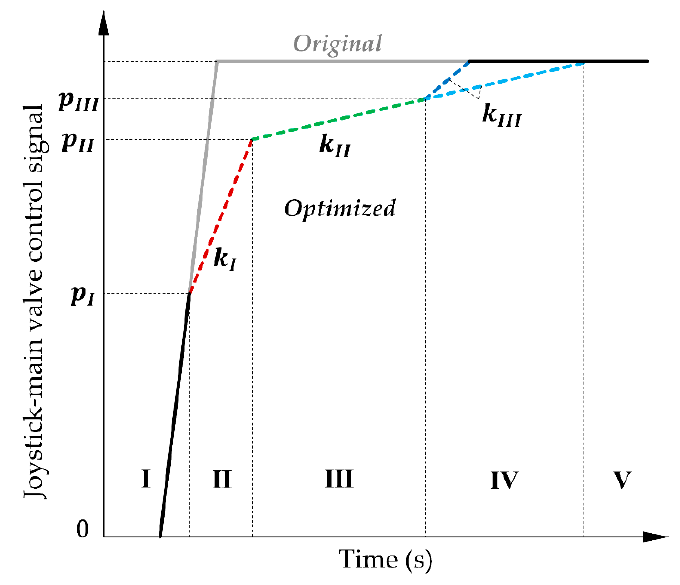
Figure 6. Five stages of main valve control signal.